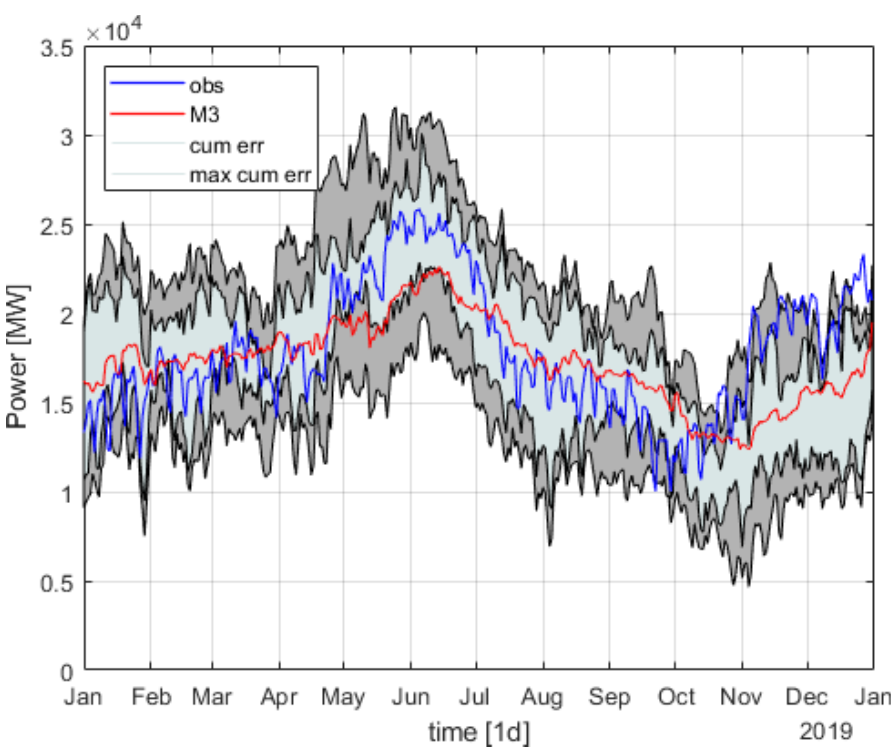
Figure 14. Total power generated by the eleven countries: observed (blue line) and modeled (red line). The gray shade is the interval of confidence computed by considering the errors over the training